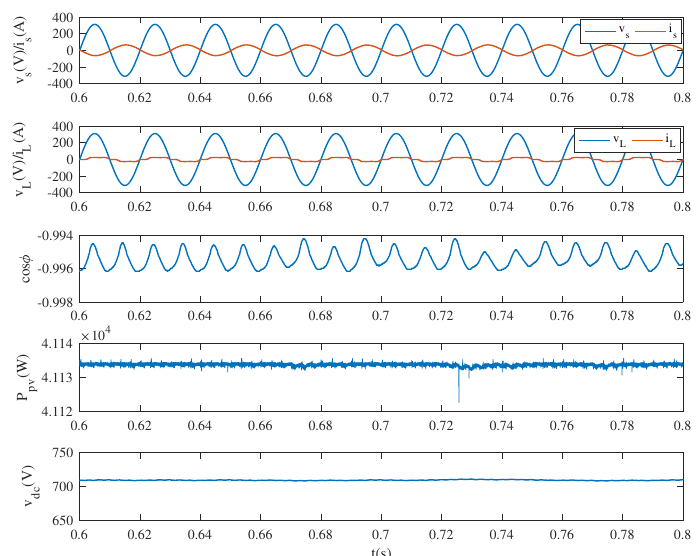
Figure 8. Simulation results of harmonic and reactive power compensation with 0 < P L < P p